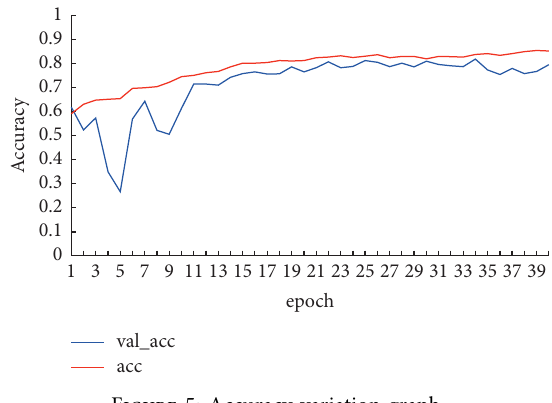
Figure 5: Accuracy variation